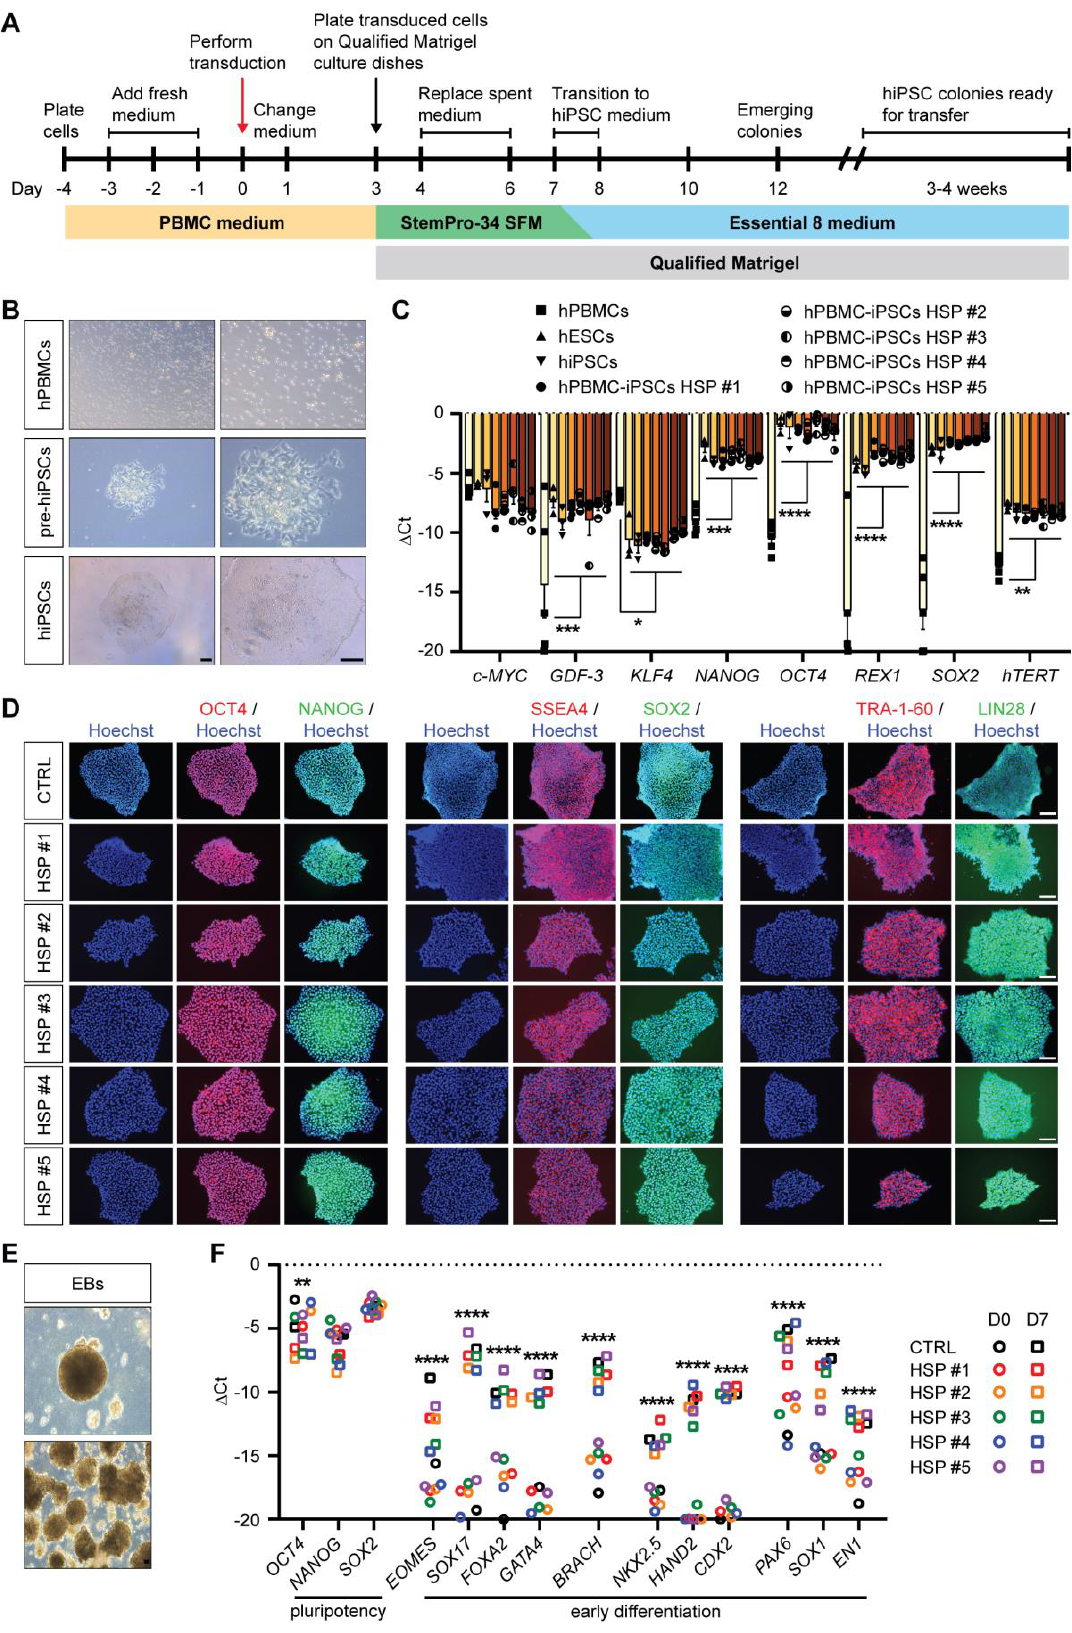
Figure 2. Characterization of the SeV-mediated reprogrammed HSP-patient hPBMC-iPSC clones. ( A ) Schematic representation of the SeV reprogramming protocol. hPBMCs HSP-derived lines (#1, #2, #3 for SPG3a - and #4, #5 for SPG4 -mutated genotypes) were transduced at day 0 using the